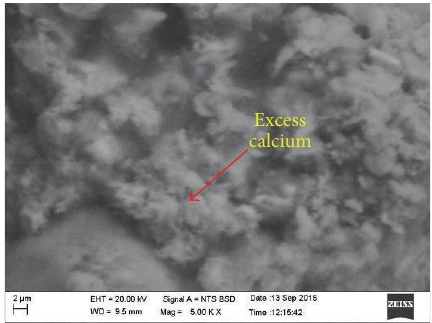
Figure 7: SEM image for SFCS25 specimen.